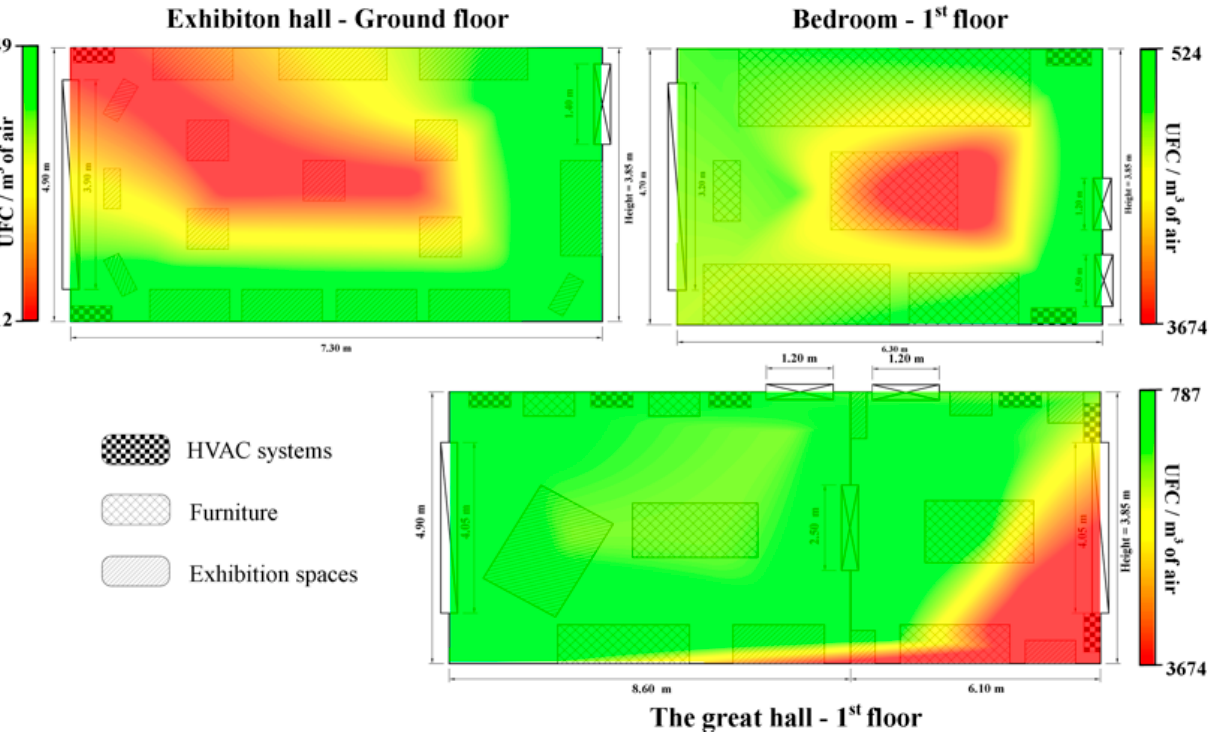
Figure 5. Spatial distribution of the number of units that form fungal colonies per m 3 of air in the three analyzed rooms in Darvas-La Roche House.